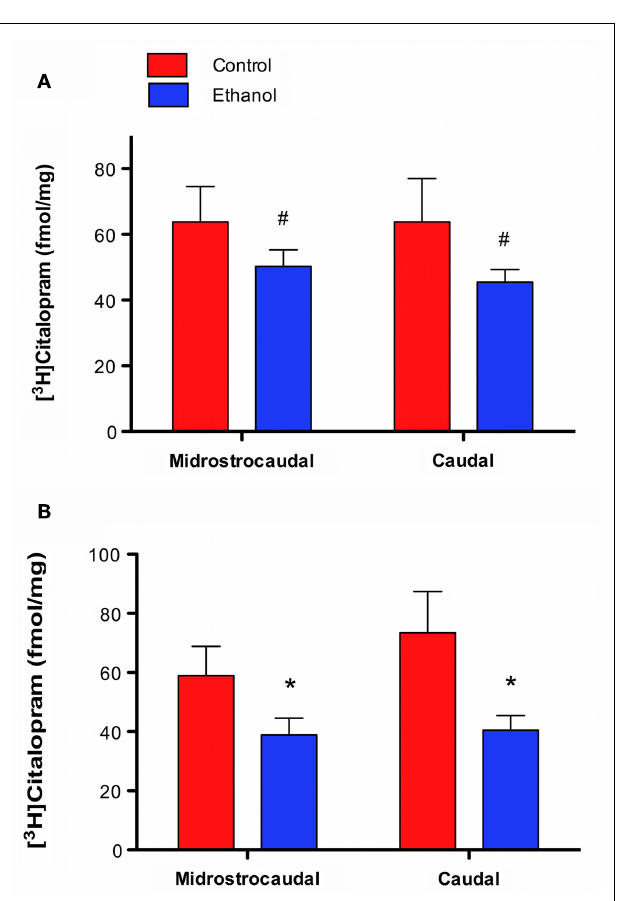
FIGURE 2 | [ 3 H]Citalopram binding is lower in animals that chronically self-administered ethanol. (A) CA1slm [ 3 H]citalopram binding is lower in ethanol drinkers than controls. (B) DGmol [ 3 H]citalopram binding is significantly lower in ethanol drinkers than controls. # p = 0.08; * p <